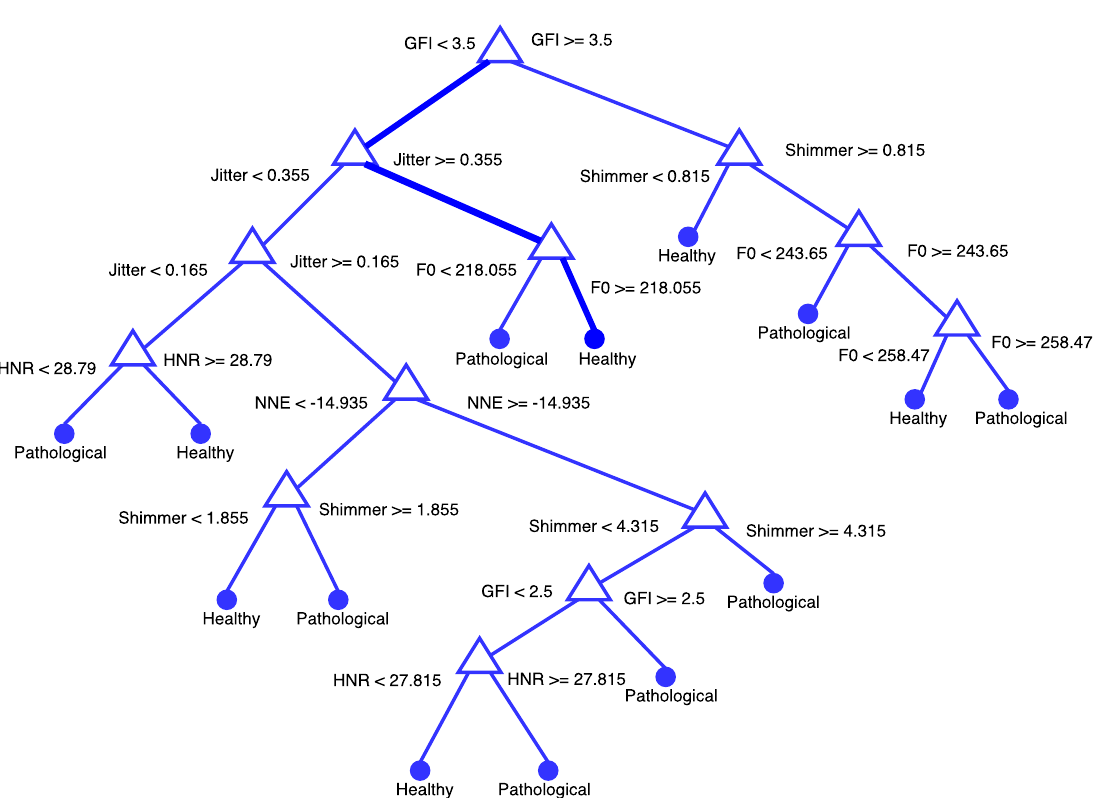
Figure 2. A fragment of the decision tree created using the six audio parameters and the GFI (Glottal function index)